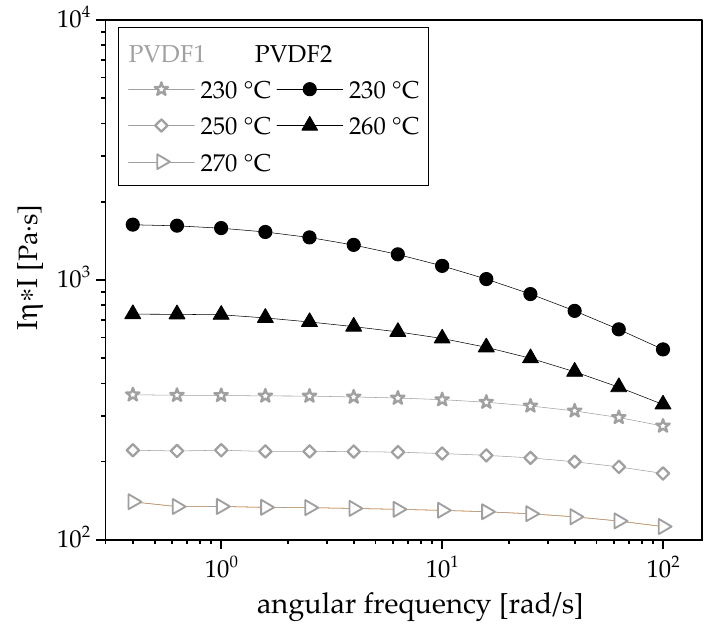
Figure 1. Complex melt viscosity I η *I in dependence on the angular frequency of pure poly (vinylidene fluoride) (PVDF), PVDF1 and PVDF2 measured at different temperatures.